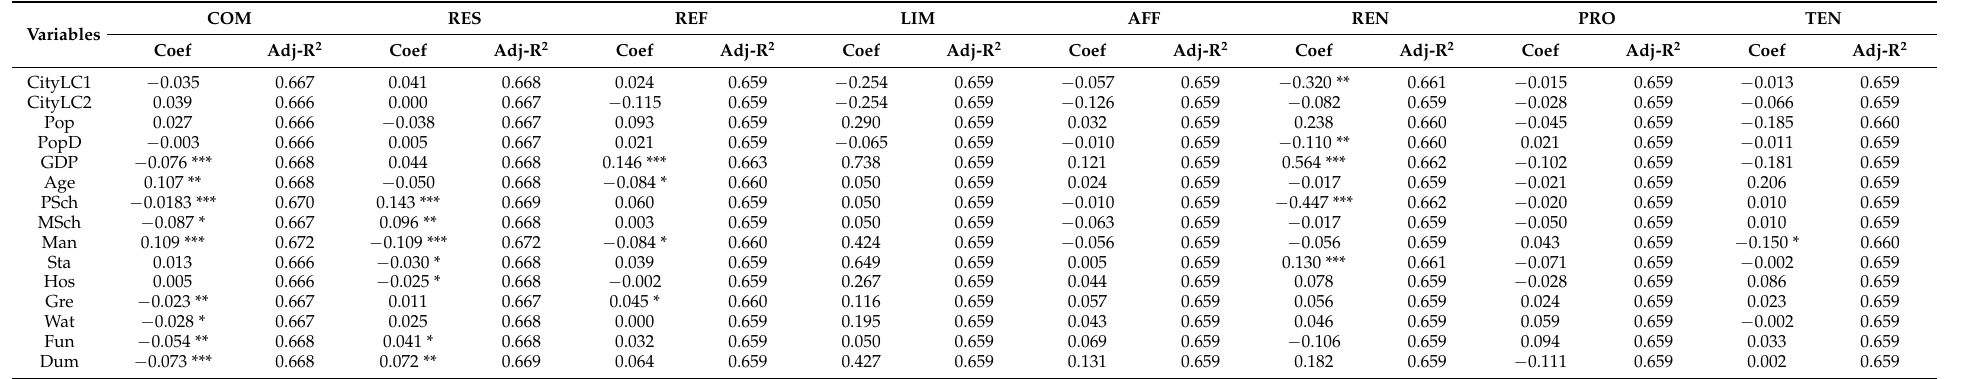
Table 5. Interactive regression results of the residence types (N = 1079).